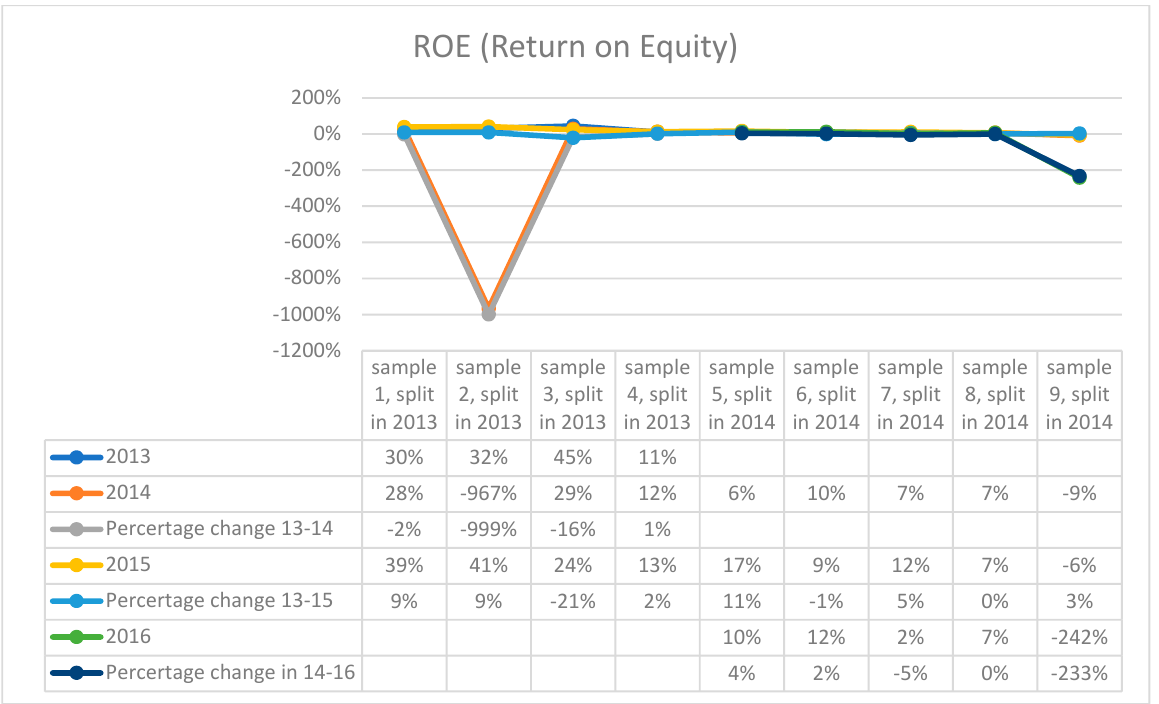
Figure 9 . ROE ratio evolution from 2013 to 2014. Figure 9. ROE ratio evolution from 2013 to Table 3. Samples with positive ROE.